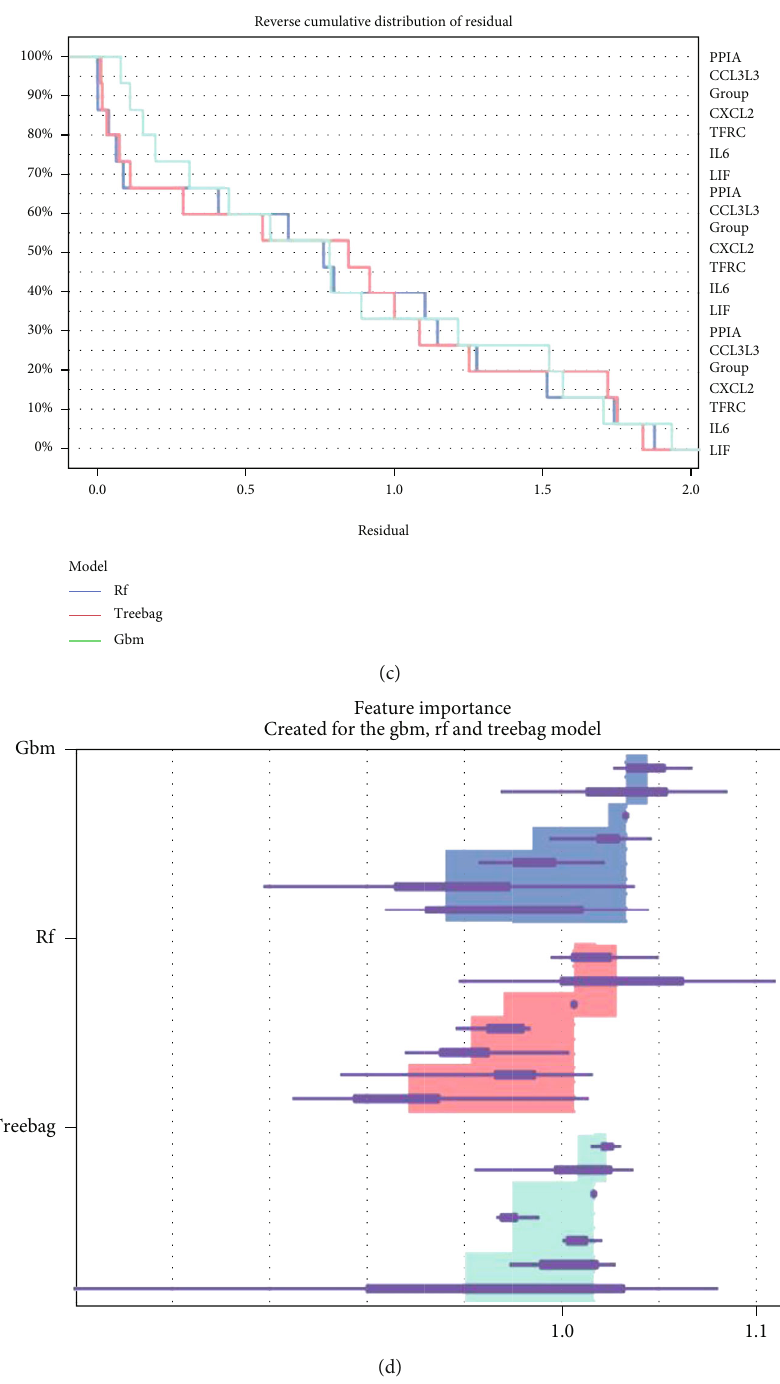
Figure 3: Construction and assessment of RF, GBM, and treebag model. (a) Elastic net of 34 DIRGs in GSE116626. The main parameters are alpha = 1 and lamda = 6 (CV.Glmnet function automatically produces the most appropriate value.). (b) Cumulative residual distribution map of the sample. (c) Boxplots of the residuals of the sample. Red dot stands for root mean square of residuals. The residual distributions were very close in the three models. (d) Importance of the variables in RF, GBM, and treebag model. The six DIRGs have di ff erent importance in three